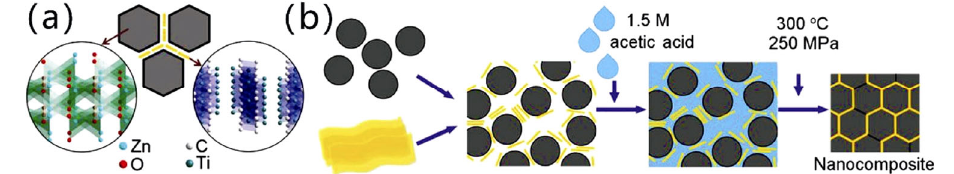
Fig. 21 Schematic illustration showing the fabrication process via cold sintering. Reproduced with permission from Ref. [200], © WILEY-VCH Verlag GmbH & Co. KGaA, Weinheim 2018